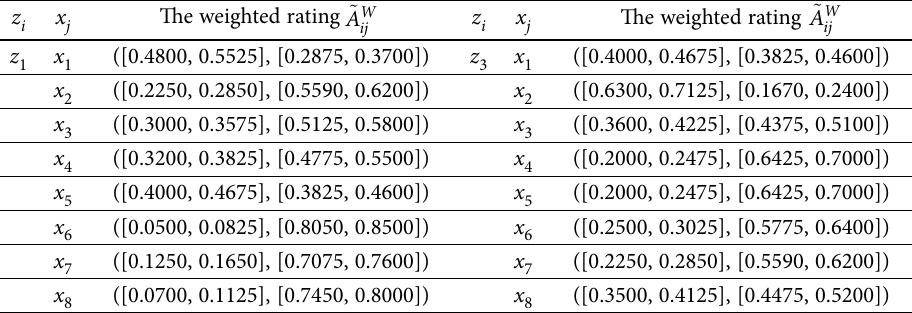
Table 4. Results for the weighted evaluative